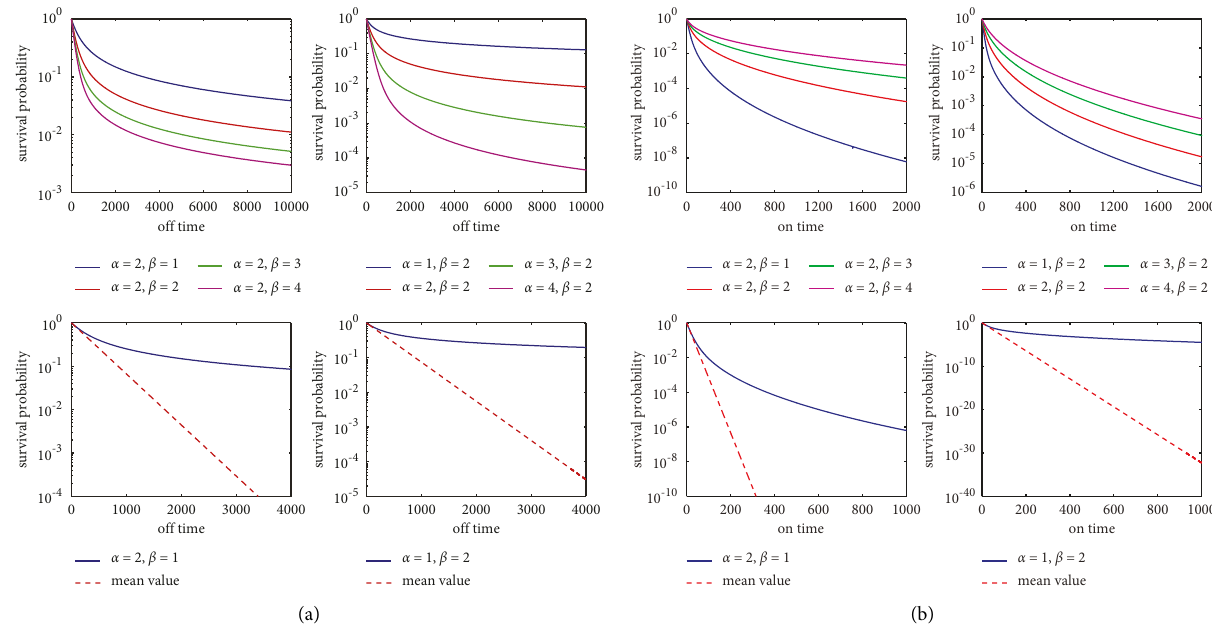
Figure 2: The input signal induces dwell time drift with an activator. The first row represents the upstream input as noise, whereas the second row represents the difference in the dwell time between the noise and noiseless signals. (a) The OFF-state dwell time under the FM paradigm with the extracellular stimulus increasing its burst frequency or burst size; (b) the ON-state dwell time under the AM paradigm when the extracellular stimulus strength increases, and the means of the coloured lines are similar to (a). Other parameters are set as